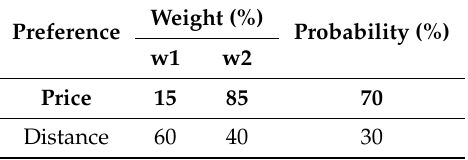
Table 7. Weights for the user price preference scenario.